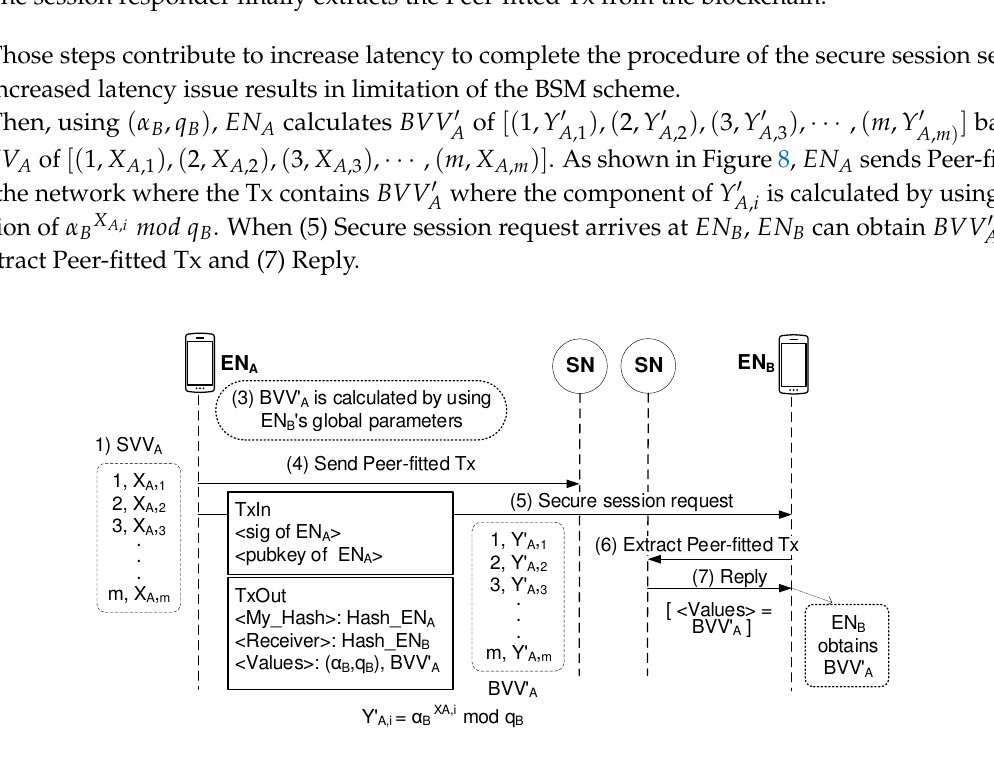
Figure 8. Sending Peer-fitted Blind Value Vector information via